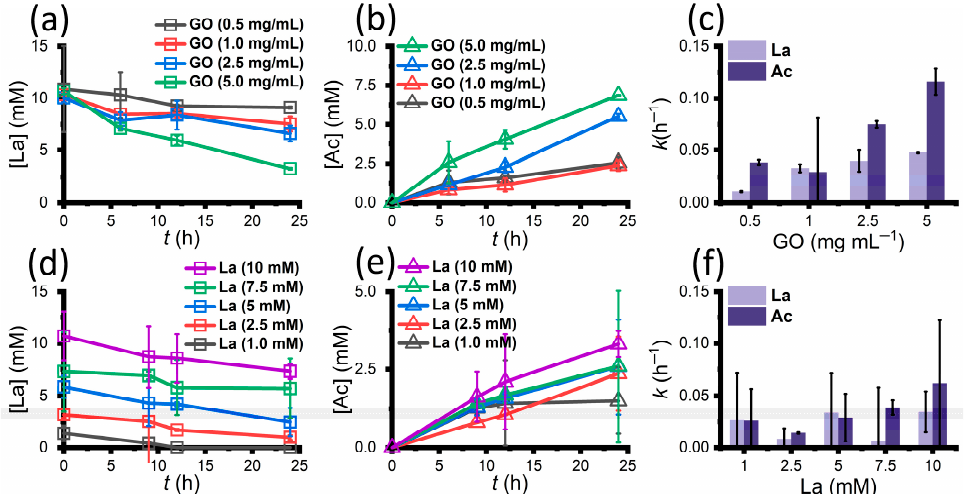
Figure 7. Organic-acid profiles and k -value estimations obtained with the controlled initial inoculation (OD 600 = 0.4–0.5) coupling different experimental conditions, including consistent 10 mM of initial lactate with different GO concentrations ( a – c ) and 1.0 mg mL − 1 of initial GO with different lactate concentrations ( d – f ). ( a , d ) lactate profiles; ( b , e ) acetate profiles; ( c , f ) estimated k values; GO, graphene oxide; La, lactate; Ac, acetate.